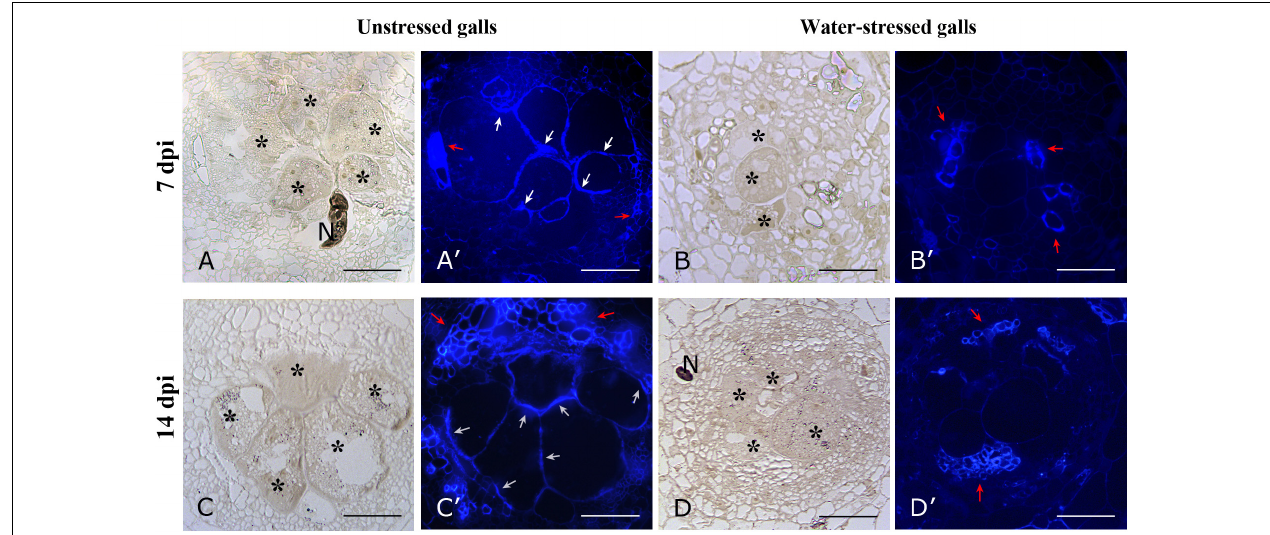
FIGURE 7 | Bright field and fluorescence microscope images of cellulose distribution in cross sections of unstressed (RKN) and water-stressed (RKN_WS) galls stained with Calcofluor-white. Blue fluorescence was present on cellulosic walls of GCs and vessels of unstressed galls at 7 (A (cid:48) ) and 14 dpi (C (cid:48) ) . No signals were detectable on GCs walls of water-stressed galls both at 7 and 14 dpi (B (cid:48) ,D (cid:48) ) , only xylem vessels showed fluorescence. Bright field images of corresponding sections of unstressed (A,C) and water-stressed galls (B,D) . Asterisks indicate GCs; N, nematode; white arrow, cellulosic cell walls; red arrow, vessels; scale bar, 100 µ